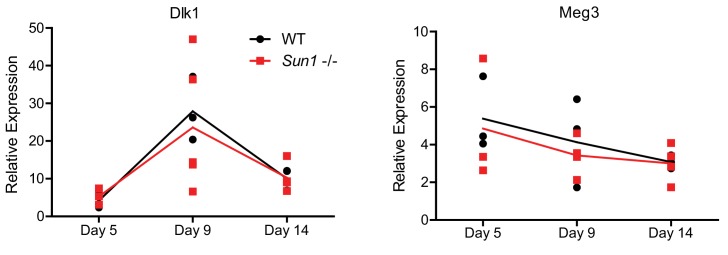
The Dlk1 and Meg3 imprinted genes in autografts of WT and Sun1–/– mice were quantified by RT-qPCR and did not show any significant differences.